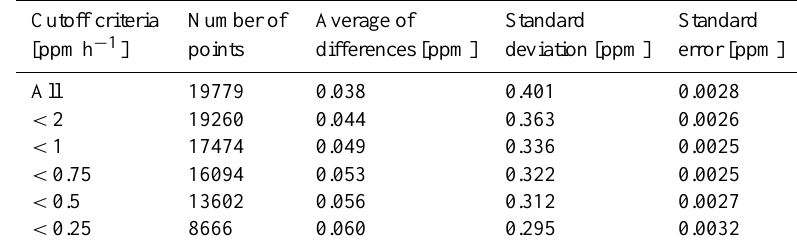
Table 4. The statistics of different cutoff criteria of rapid CO 2 mole fraction changes and their influence on the number of points remaining, the average of the hourly differences of the NDIR and the CRDS system, the standard deviation of the differences and the according standard errors. The differences between the cutoff criteria are most probably caused by different volumes and flow rates of the systems and small time lags in the time stamps. The measurement precision of each system is about 10 times better than the standard deviation of the differences.